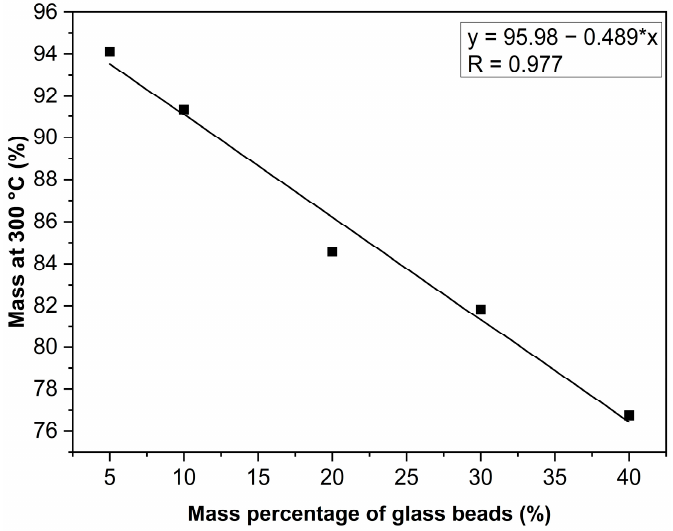
Figure 4. TGA records for pure PCL, glass beads, and their mixtures.